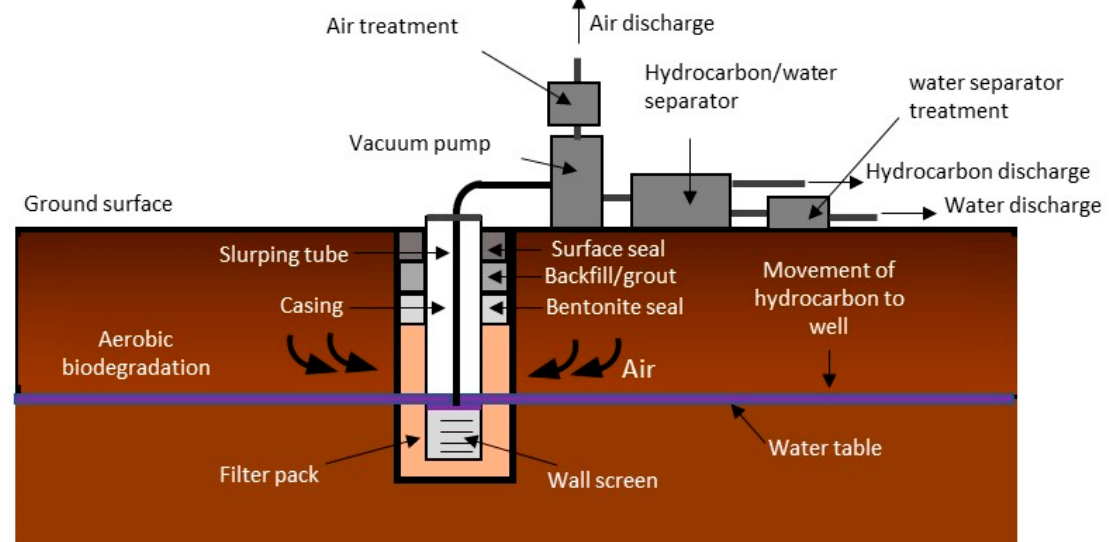
Figure 4. Scheme of operation of bioslurping (adapted from [3]).